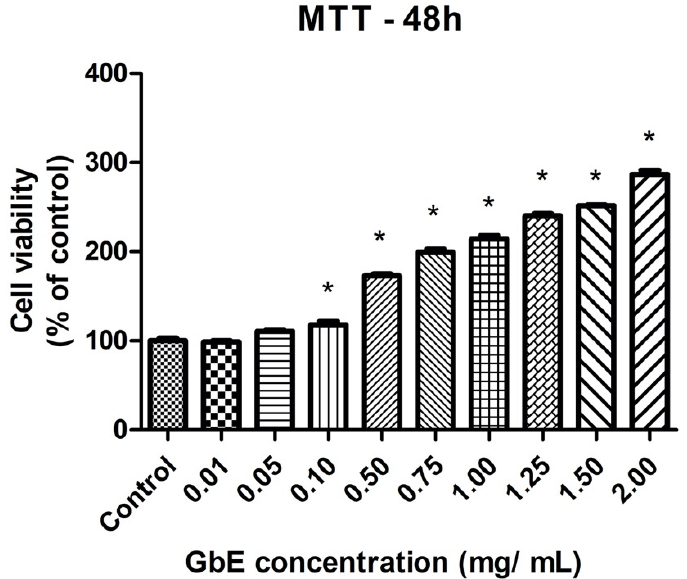
Figure 1. GbE enhanced cell viability of 3T3-L1 preadipocytes determined by MTT assay. 3T3-L1 preadipocytes were incubated without or with GbE in different concentrations for 48 h. Results were normalized as % of control. Values are expressed as mean ± SEM ( n = 7). One-way ANOVA followed by Dunnett’s post-test. * p < 0.05 vs. control.